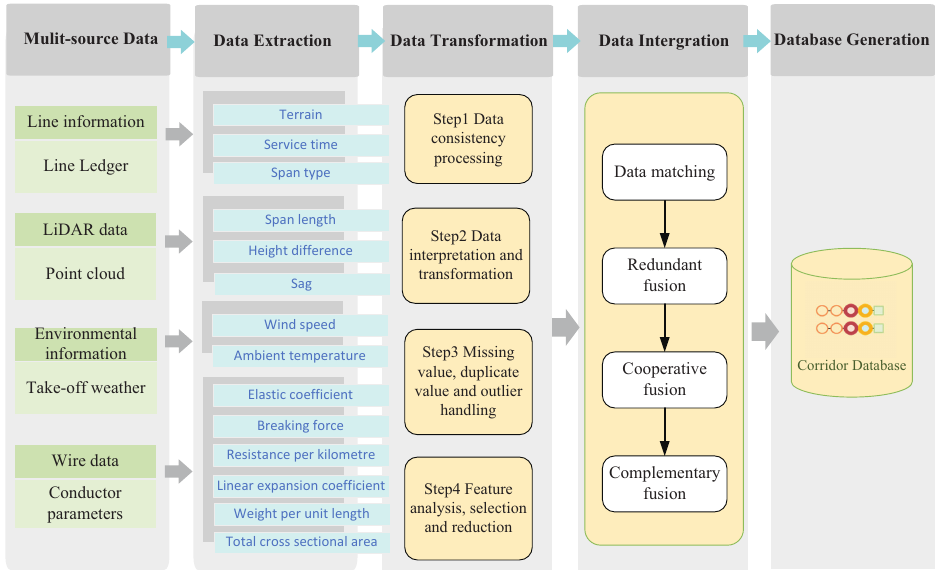
Figure 3. The framework of data